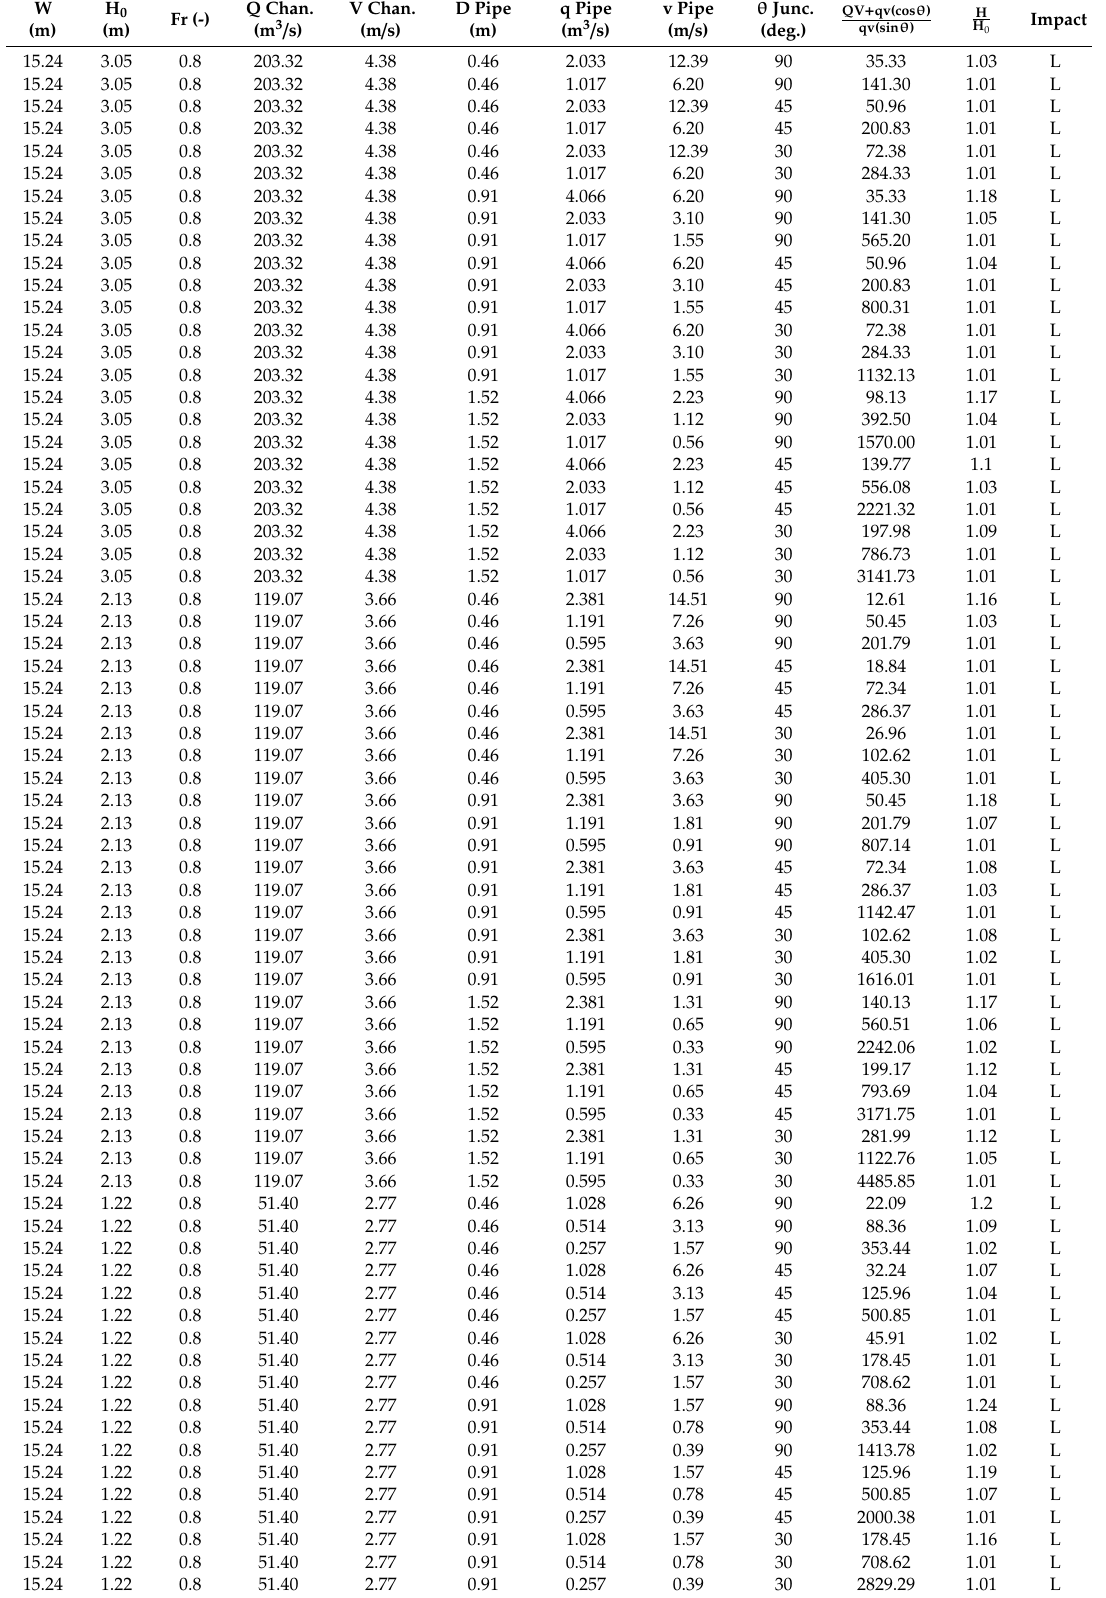
Table A9. FLOW-3D simulation results for W = 15.24 m (50 (cid:48) ) and Fr =